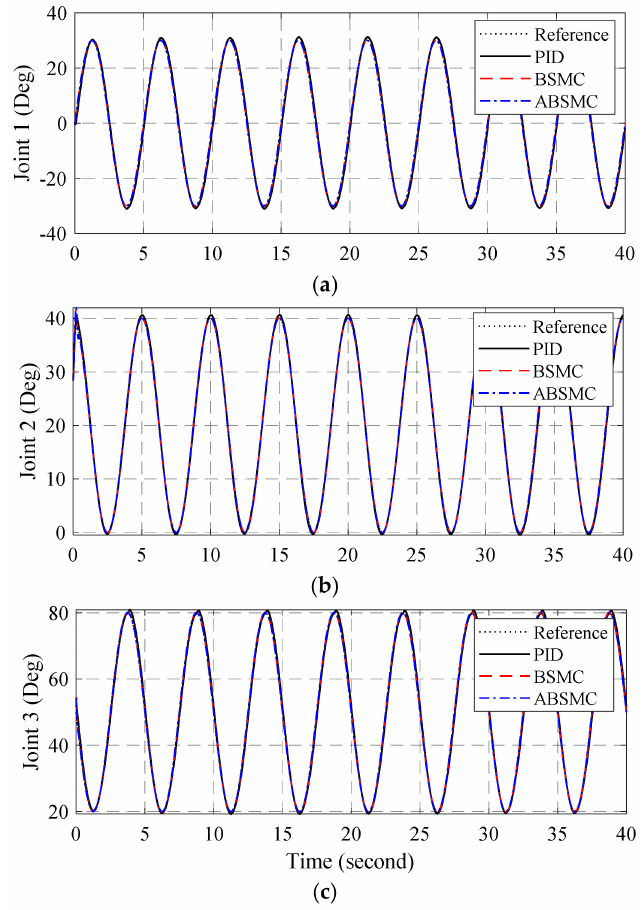
Figure 4. Joint responses of PID, BSMC, and ABSMC in ( a ) joint 1, ( b ) joint 2, ( c ) joint 3.